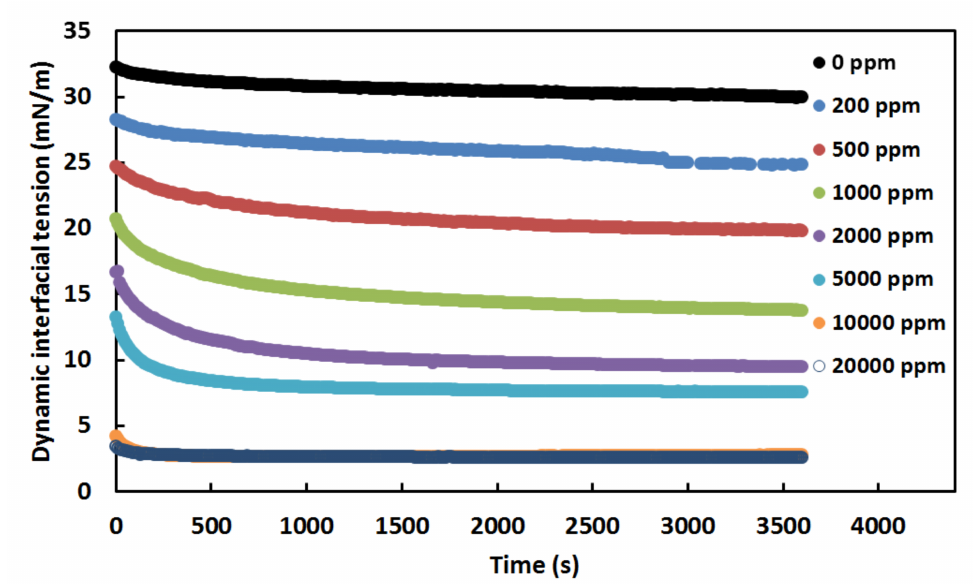
Figure 2. Dynamic crude oil-water interfacial tensions at various Span 80 concentrations.